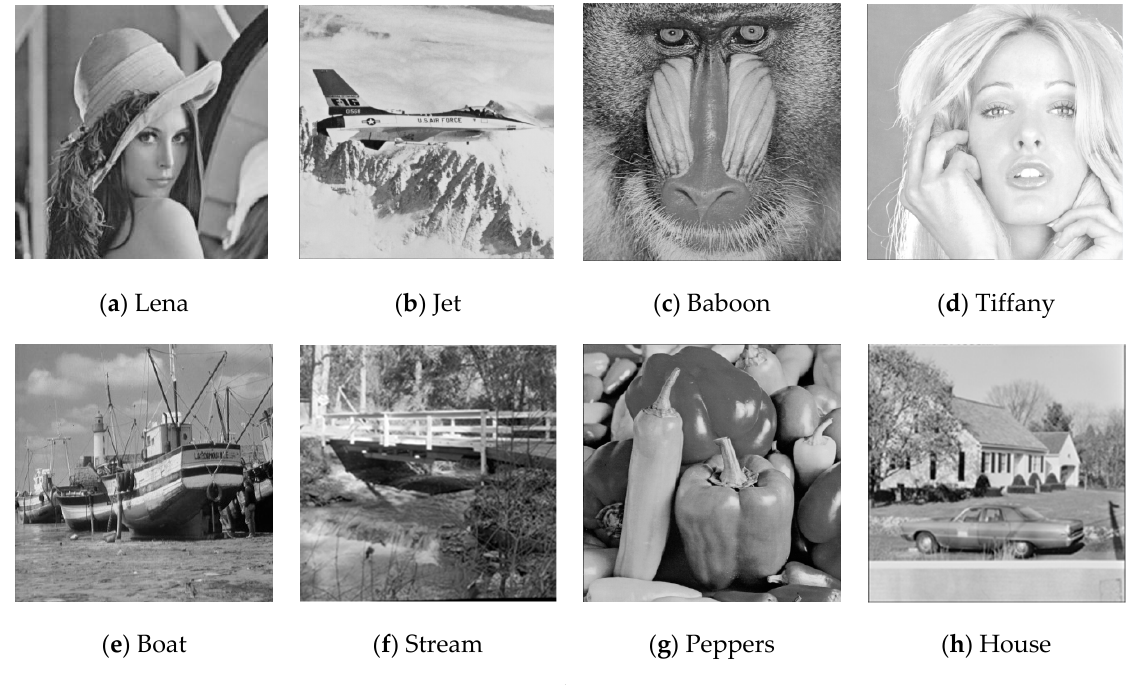
Figure 4. Eight test images.